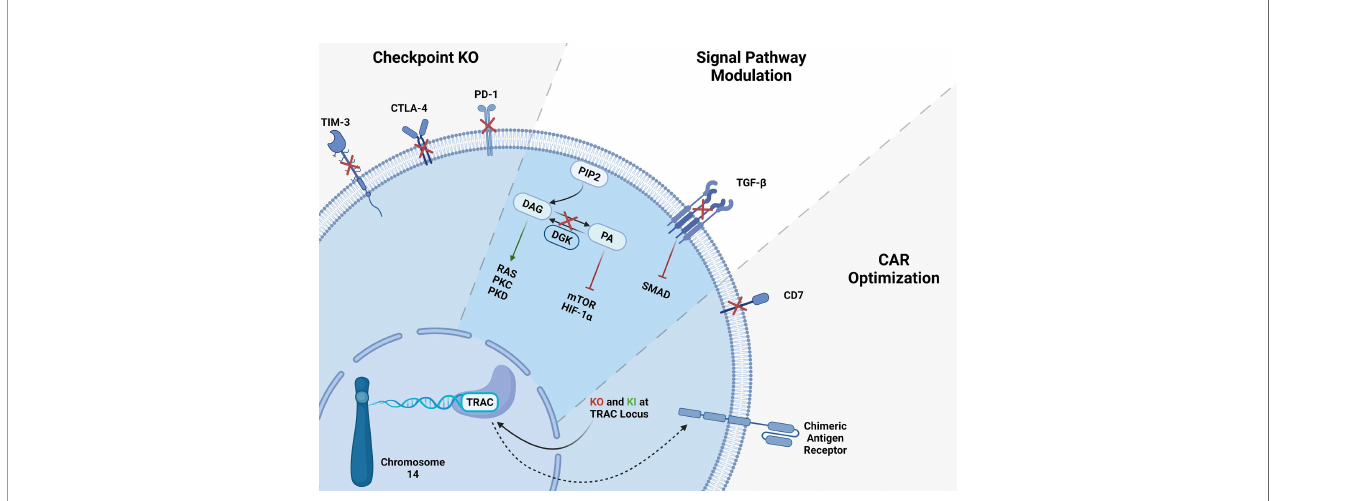
FIGURE 1 | CRISPR gene editing in T-cells. Several gene KO and KI have been tested in T-cells, here we summarized the targeted genes. T cell checkpoint inhibitory receptor KO such as TIM3, CTLA-4 and PD-1 KO resulted in higher antitumor activity of T-cells. CAR-T cell signaling modulation via inhibition of immunosuppressive TGF- b signaling showed signi fi cant improvement of CAR-T cells. Integration of CAR-T in TRAC locus may solve the mentioned problems with allogeneic CAR-T